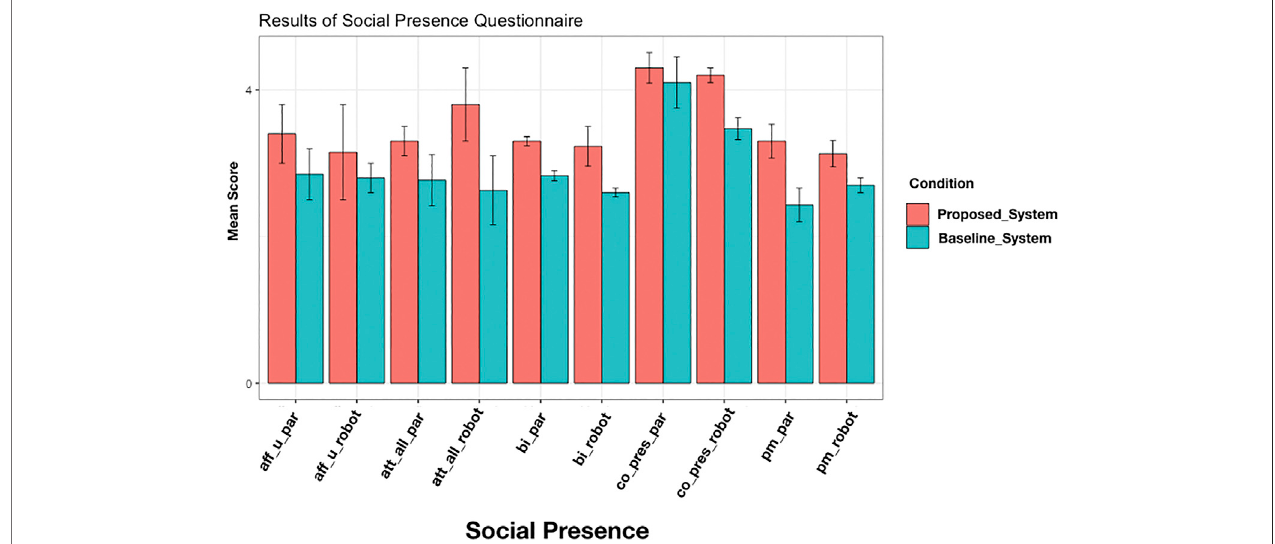
FIGURE 7 | Results of Social Presence Questionnaire. Mean values for each direction of the fi ve different social presence dimensions (Harms and Biocca, 2004)._par indicates the direction of the participant. _robot the direction of the robot (aff_u) Perceived Affective Understanding, the ability to understand the other ’ s emotional and attitudinal states (Att _all) attentional allocation, the amount of attention the user allocates to and receives from the other (bi) perceived behavioral interdependence, the extent to which the user ’ s behavior affects and is affected by the other ’ s behavior; (co_pres) co-presence, the degree to which the observer believes s/he is not alone (pm) perceived message understanding, the ability of the user to understand the message from the other.